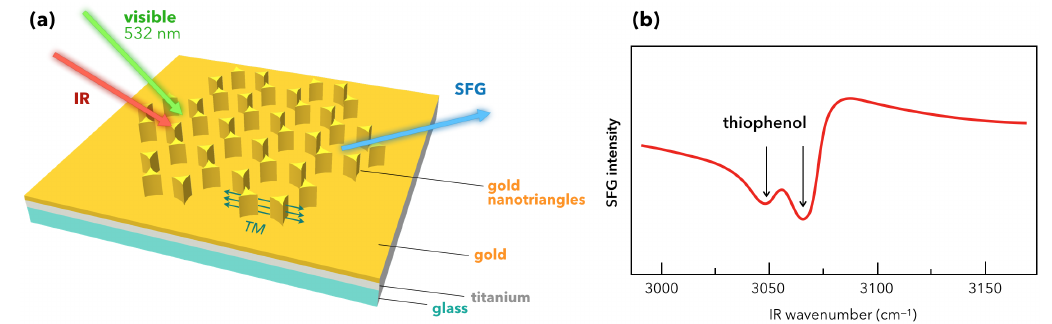
Figure 12. ( a ) Sketch of the SFG experiment performed on gold nanotriangles (AuNT) grafted by nanosphere lithography (NSL) on a gold film (30 nm thickness) deposited on a titanium